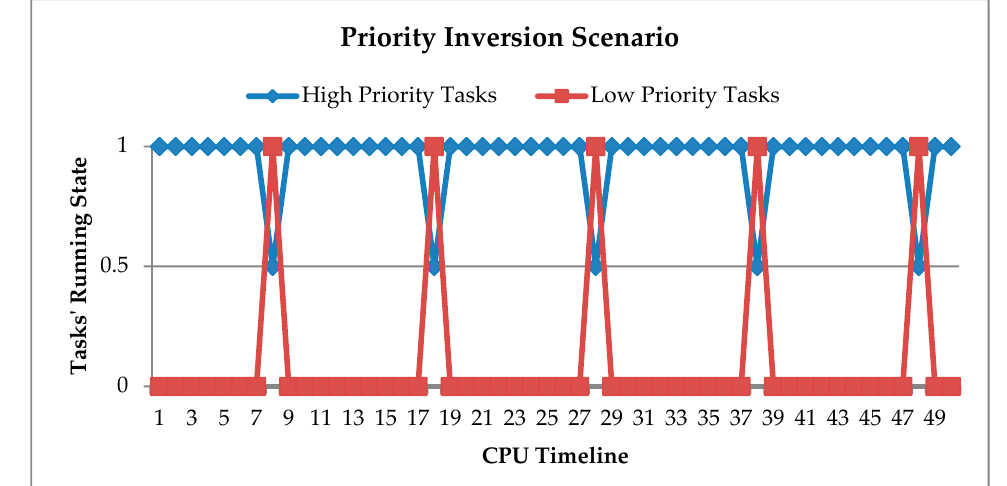
Figure 18. Response time. Electronics 2019 , 8 , x FOR PEER REVIEW